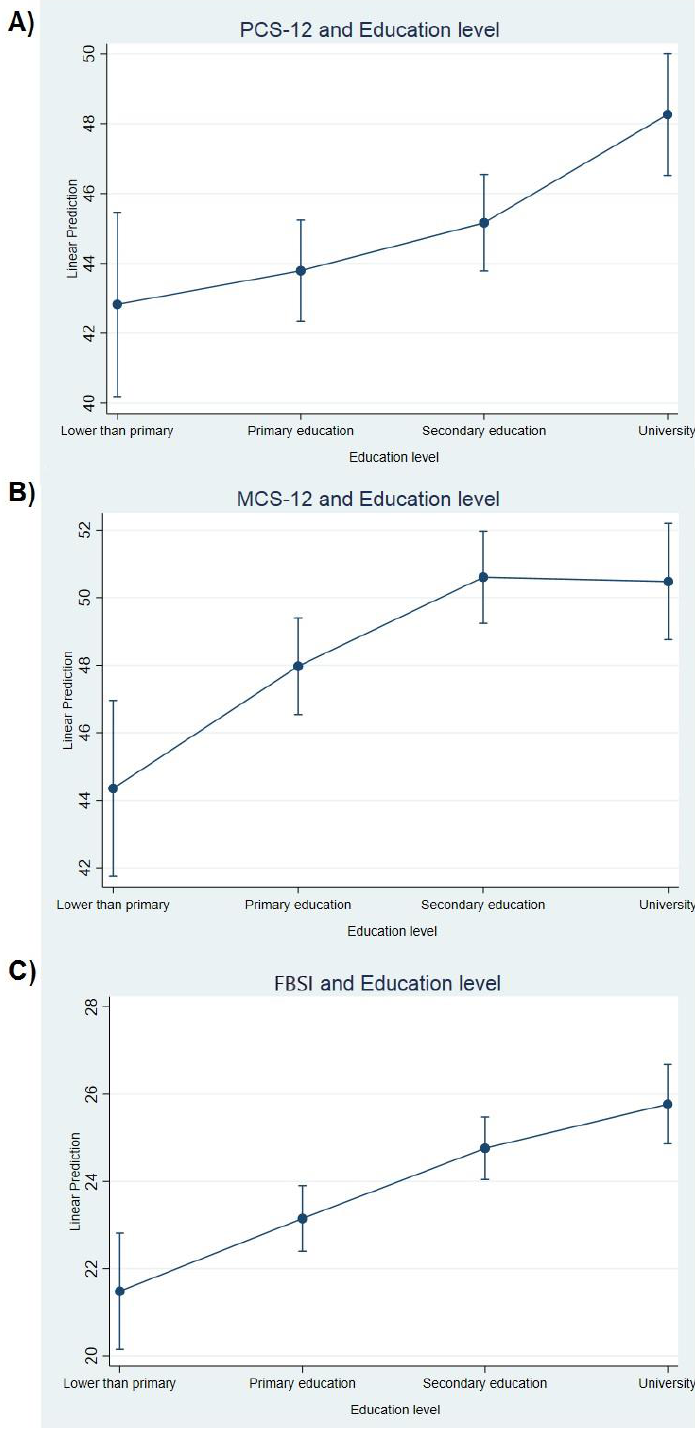
Figure 2. Relationship between Educational level and PCS-12 ( A ), MCS-12 ( B ) and FBSI ( C ).